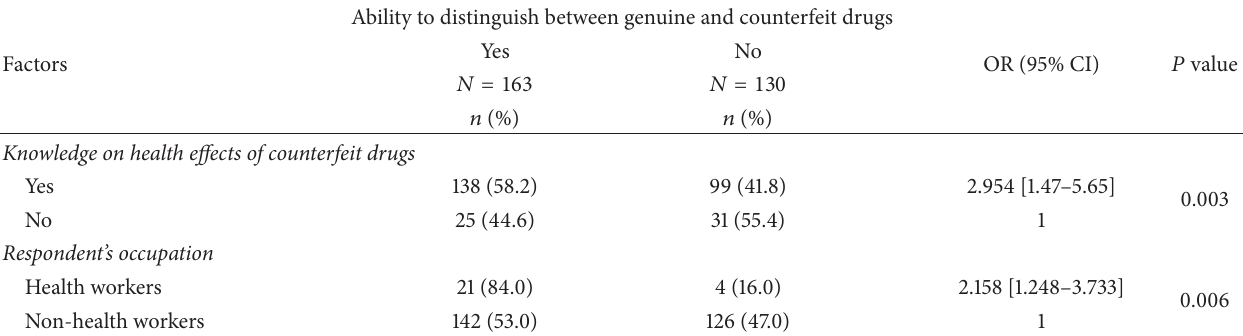
Table 5: Logistic regression on factors associated with identification of genuine and counterfeit drugs.